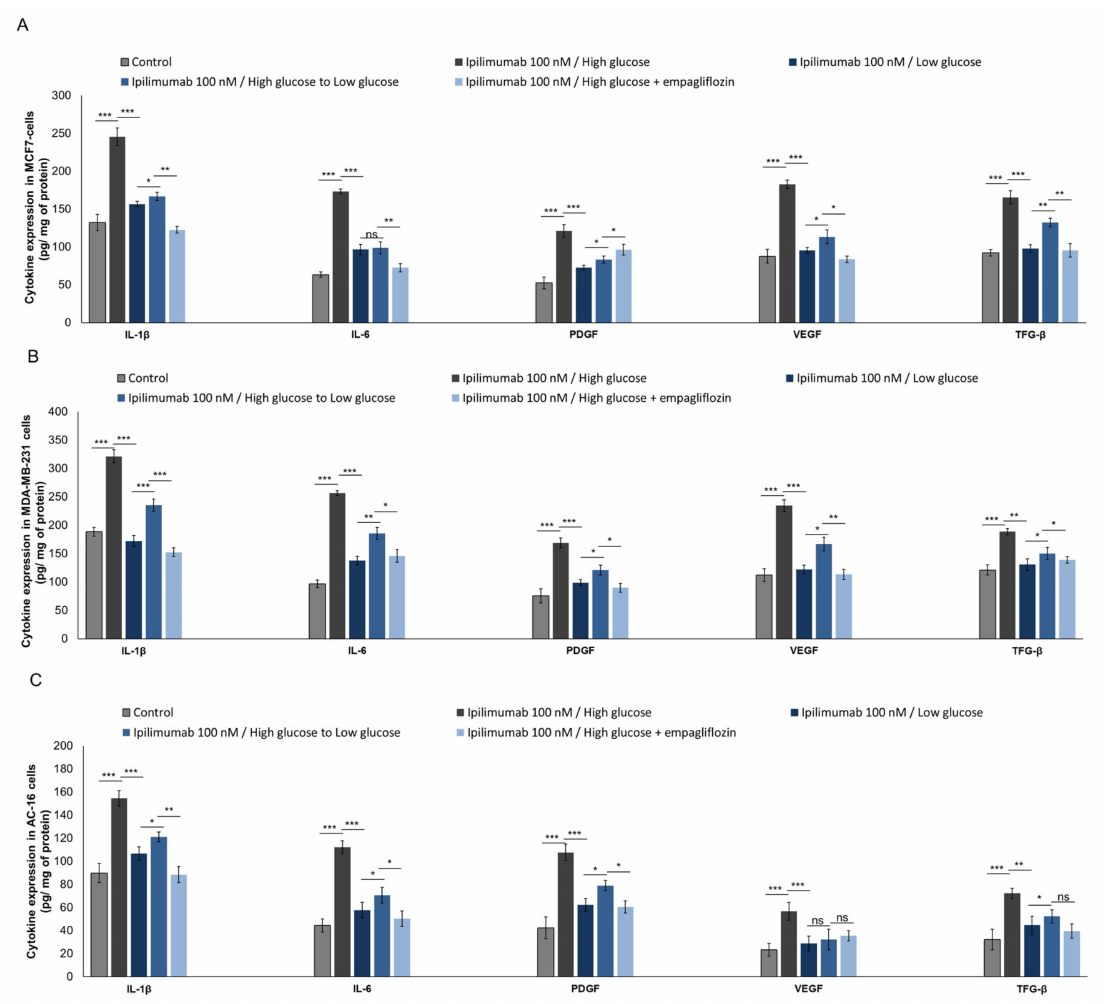
Figure 8. Expression of IL-1, IL-6, PDGF, VEGF, and TGF in MCF-7 ( A ), MDA-MB-231 ( B ), and AC-16 cells ( C ). Cells were treated with ipilimumab mAb for 24 h, in the presence of hPBMCs under di ff erent condition (high glucose; low glucose; shifting from a high glucose to low glucose; high glucose + empagliflozin at 500 nm). Error bars depict means ± SD ( n = 3). Statistical analysis was performed using paired t -test. *** p < 0.001. ** p < 0.01. * p <